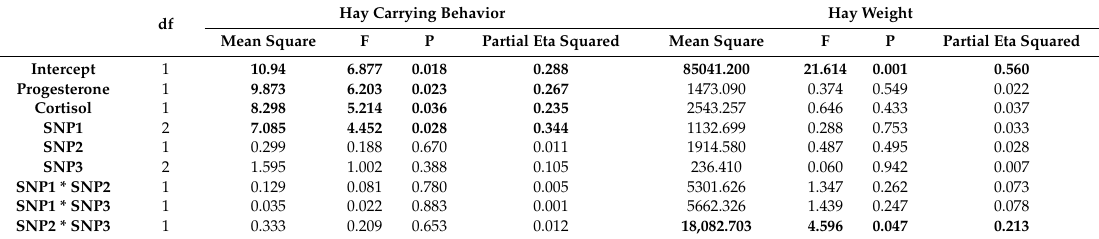
Table 4. Hay carrying behavior and hay weight in relation to polymorphism of PGR 2464G > A, 2682T > C, Exon